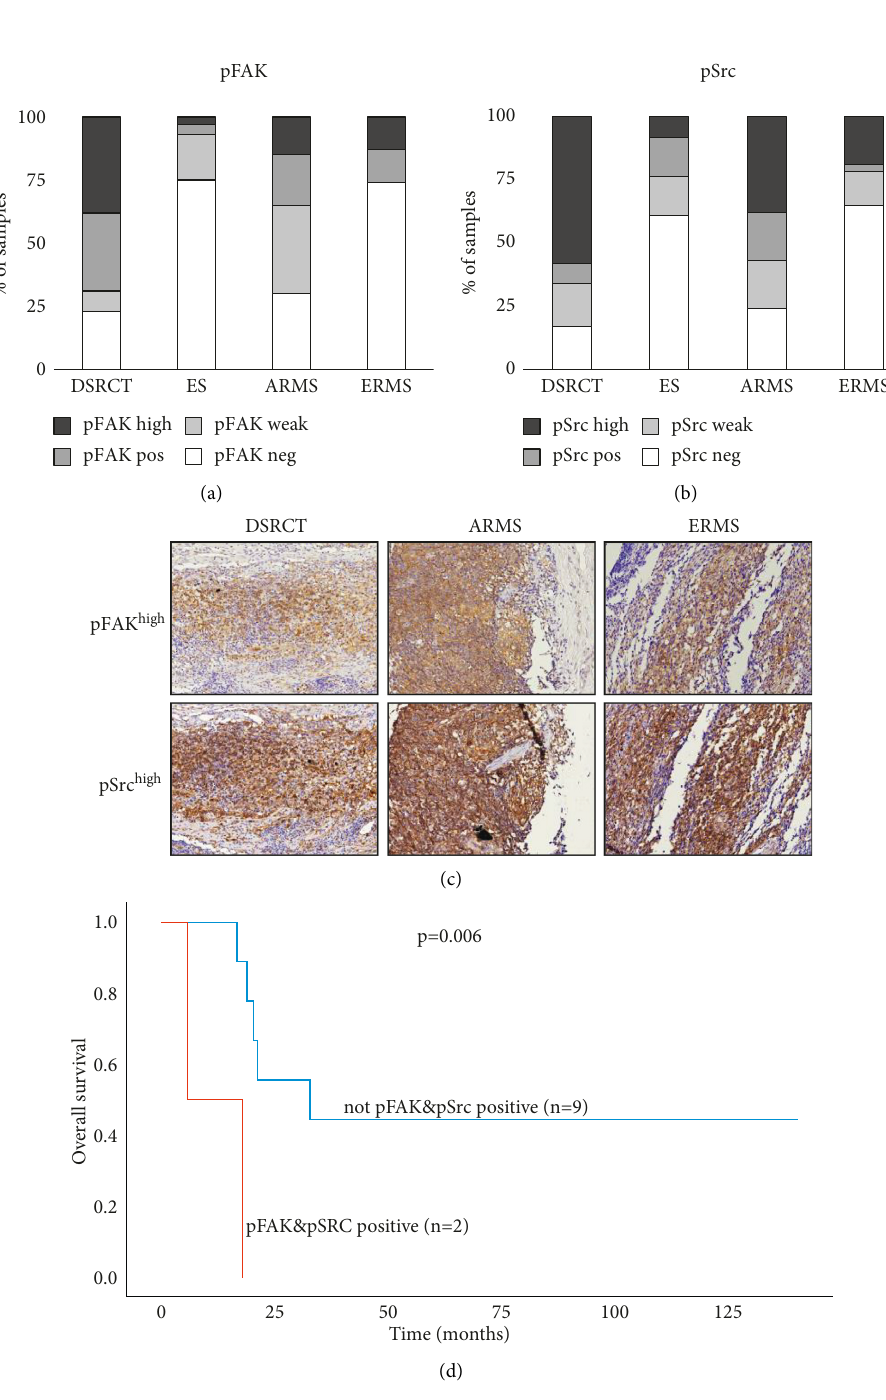
Figure 1: pFAK (Tyr397) and pSrc (Tyr416) expressions in DSRCT, ES, ARMS, and ERMS tumor tissue. (a) pFAK expression in primary and post-treatment resections, and metastatic or locally recurrent DSRCT ( n � 13), ES ( n � 68), ARMS ( n � 20), and ERMS ( n � 39) tumor tissue assessed by immunohistochemistry. (b) pSrc expression in primary and post-treatment resections, and metastatic or locally recurrent DSRCT ( n � 12), ES ( n � 64), ARMS ( n � 21), and ERMS ( n � 37). pFAK and pSrc expressions are subdivided into negative (H-score 0; pFAK/pSrc neg ), weak-positive (H-score ≤ 50; pFAK/pSrc pos ), positive (H-score 51–100; pFAK/pSrc pos ), and high-positive expression (H- score > 100; pFAK/pSrc high ). (c) Example of a pFAK high and pSrc high double-positive DSRCT, ARMS, and ERMS tumor tissue. Images taken at x 80 magnification. (d) Kaplan-Meier survival analysis of overall survival according to concurrent positive pFAK and pSrc expression in